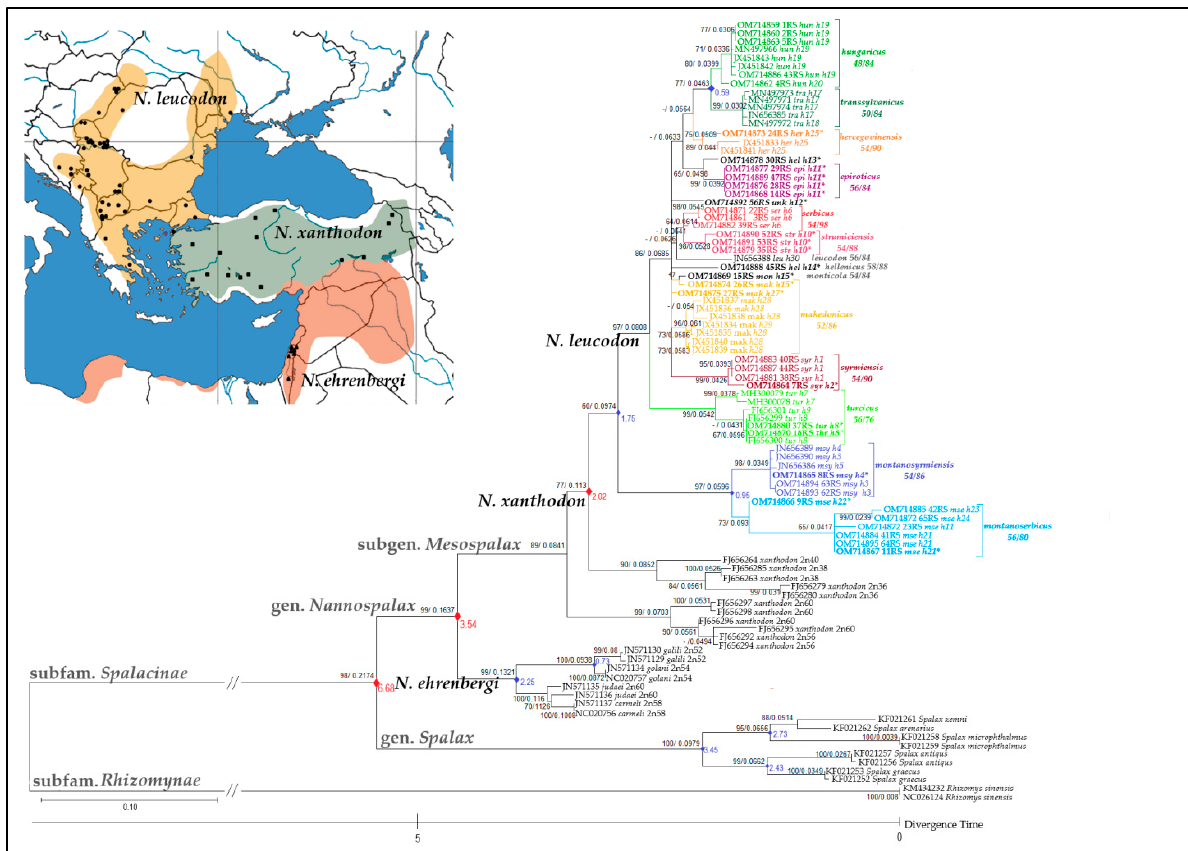
Figure 3. ML phylogenetic tree inferred from MT-CYTB nucleotide comparison. Since both methods (ML and BI) produced highly similar tree topologies, support values are placed at the nodes in that order. The dash indicates branch support < 60. Red dots—calibration constraints used in the timetree analysis; blue dots—estimated divergence time. Sequences in bold with asterisks—karyotyped samples. Geographic map shows distributional areas of the three Nannospalax superspecies, with specified sampling localities of all studied sequences (listed in Tables 1, S1 and S2, and presented in Figure S1). Source of the map: https://d-maps.com/ (accessed on 29 March 2022). The second N. leucodon clade is heterogeneous, and again contains turcicus in the basal position. Six samples from three localities revealed three haplotypes: h7 (two samples from Eceabat), h8, h9 (Kırklareli), h8 (Çorlu) and, finally, the same haplotype h8 described as